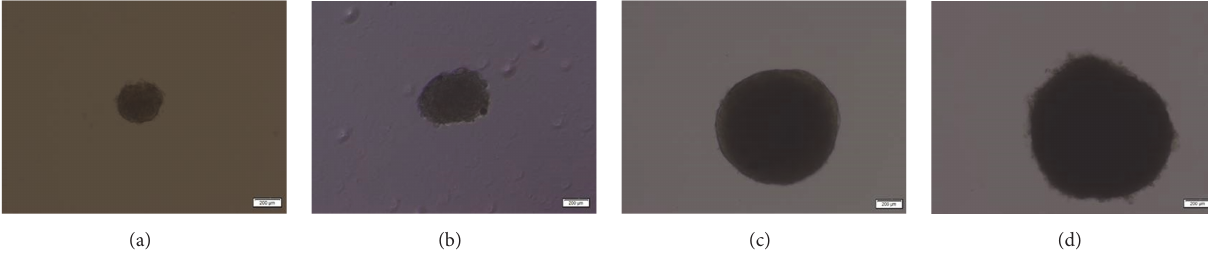
Figure 1: Gathering of MSCs into spheroids. Microscopic images showing MSCs seeded at four different concentrations (2.5 × 10 3 , 6.25 × 10 3 , 25 × 10 3 , and 50 × 10 3 cells/drop) aggregated into spheroids different in size in a hanging drop. Scale bar = 200 um.